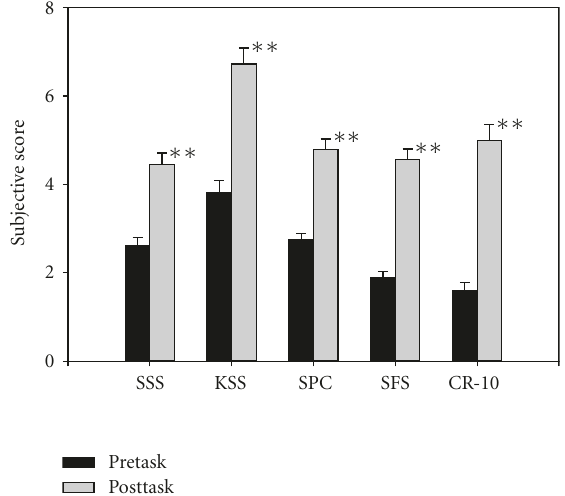
Figure 2: Comparison of several subjective scores on mental fatigue between two sessions. Pretask (before task), posttask (immediately after task). SSS, Stanford sleepiness scale; KSS, Karolinska sleepiness scale; SFC, Samn-Perelli checklist; SFS, Li’s subjective fatigue scale; CR-10, Borg’s CR-10 scale. ∗∗ P < . 005, statistical significance of di ff erence between two sessions.